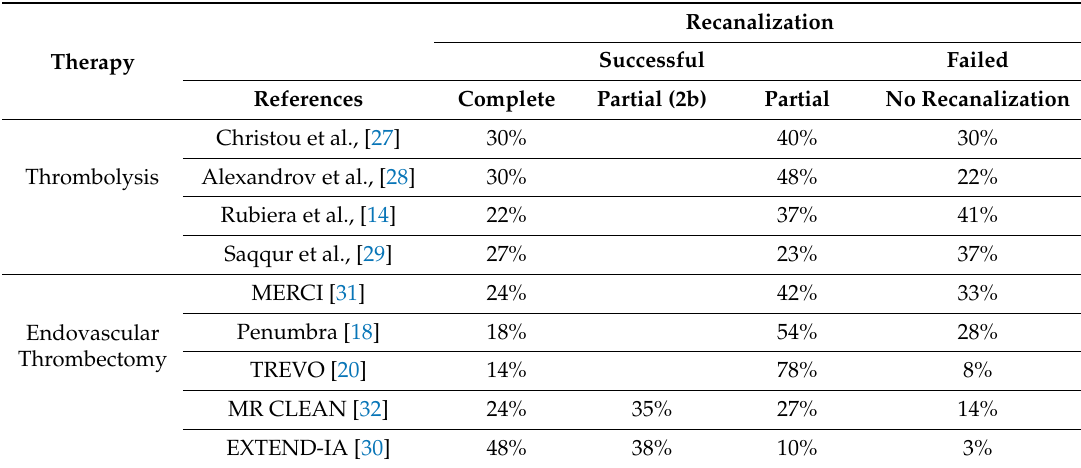
Table 1. Recanalization patterns after rt-PA thrombolysis in clinical